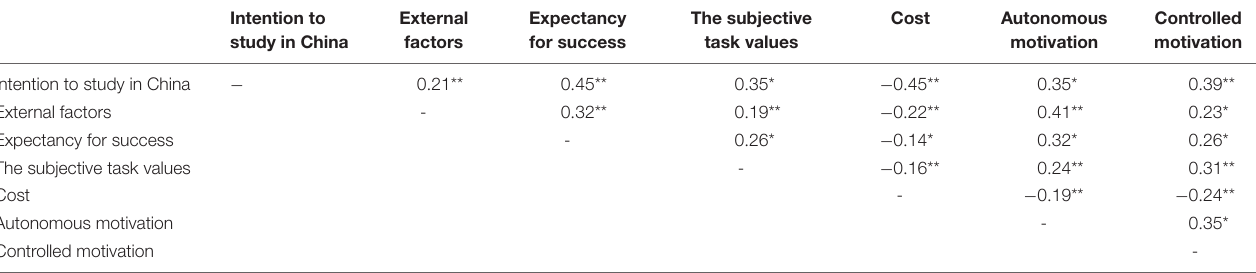
TABLE 2 | Bivariate correlations between